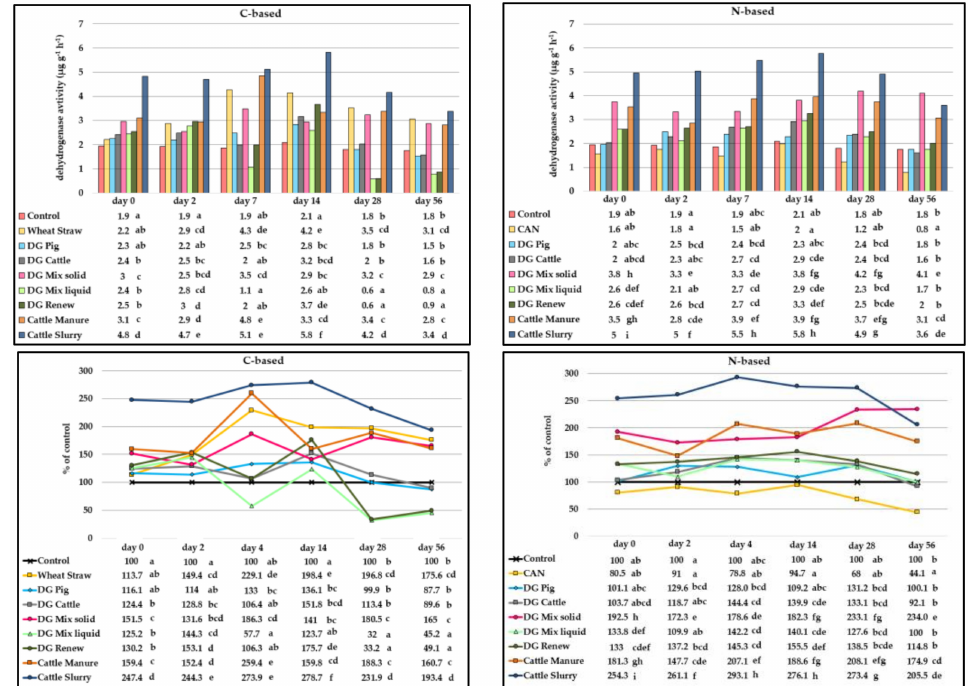
Figure 5. Dehydrogenase activity in the laboratory experiment with a C-based ( left figures ) and N-based setup ( right figures ). Bars show absolute values; lines show percentage of DHA in comparison to the control (control = 100%). Di ff erent letters mark significant di ff erences between treatments within one column, viz. on the respective day of measurement (Tukey’s HSD test, p ≤ 0.05, n =